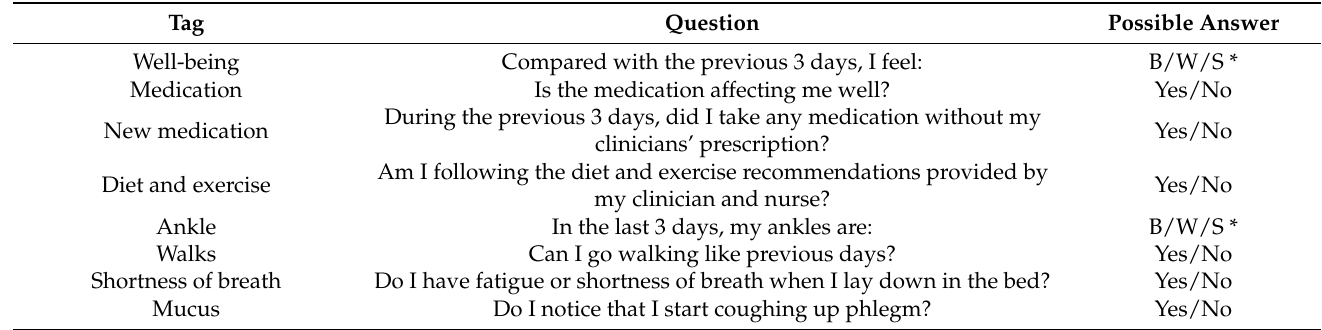
Table 2. Questionnaire that patients answered daily; previously presented in